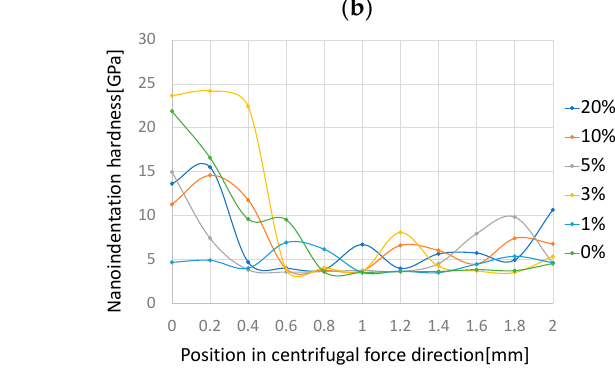
Figure 13. Nanoindentation hardness in cross sections in centrifugal directions in the samples with the rotation speeds of 250 rpm ( a ) and 1000 rpm ( b ) for a variety of amounts of PCA.